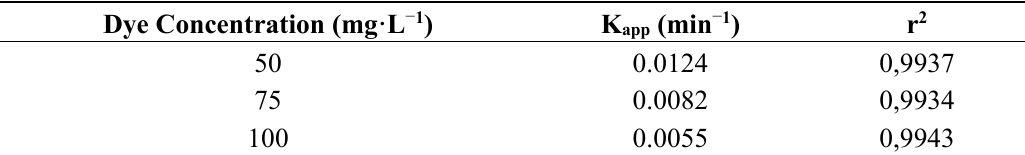
Figure 8. Relationship between ln (C/C 0 ) and treatment time (t = 180 min and 1 g·L − 1 TiO 2 ). The results indicated that the degradation of DR73 fitted first-order kinetics and it followed the Langmuir-Hinshelwood model (Table 2). The value of k app decreased with the increasing of the dye concentration. Table 2. The pseudo-first-order degradation rate constants of DR73 at different initial dye concentrations and 1 g·L − 1 TiO 2